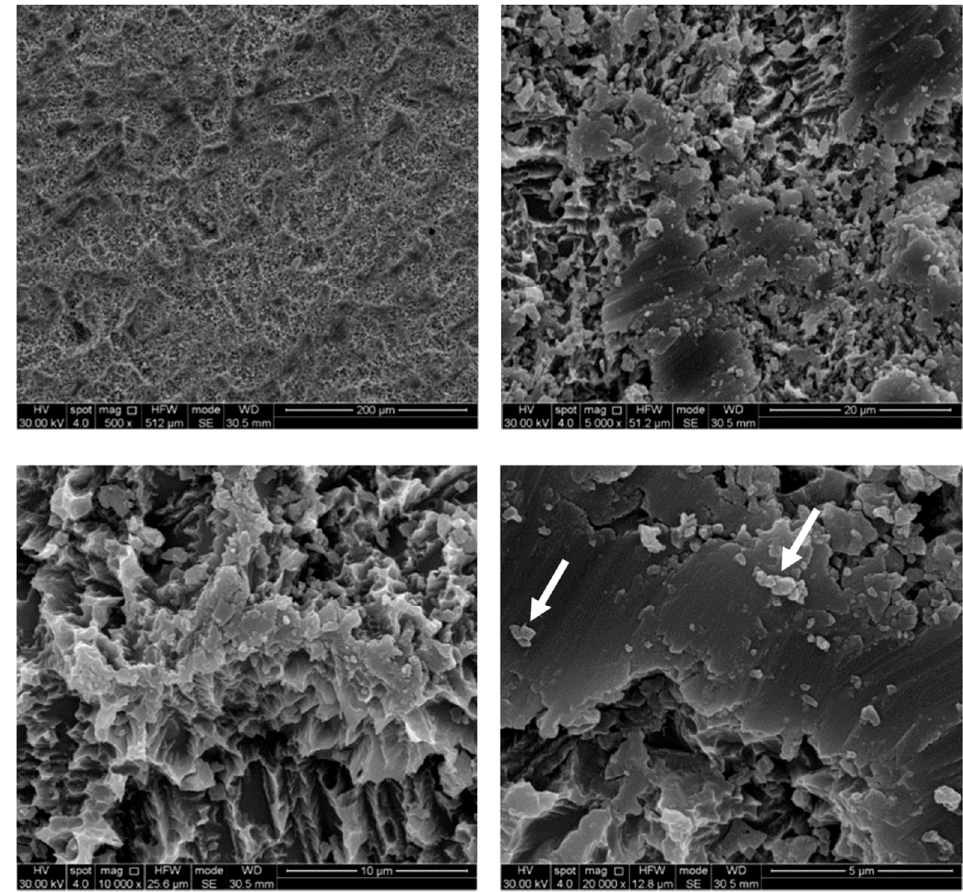
Figure 4. SEM images of titanium brush (TB) samples. Smoothed portions and titanium particles (white arrows) are clearly visible at high magnifications. Magnifications from 500× to 20,000×.